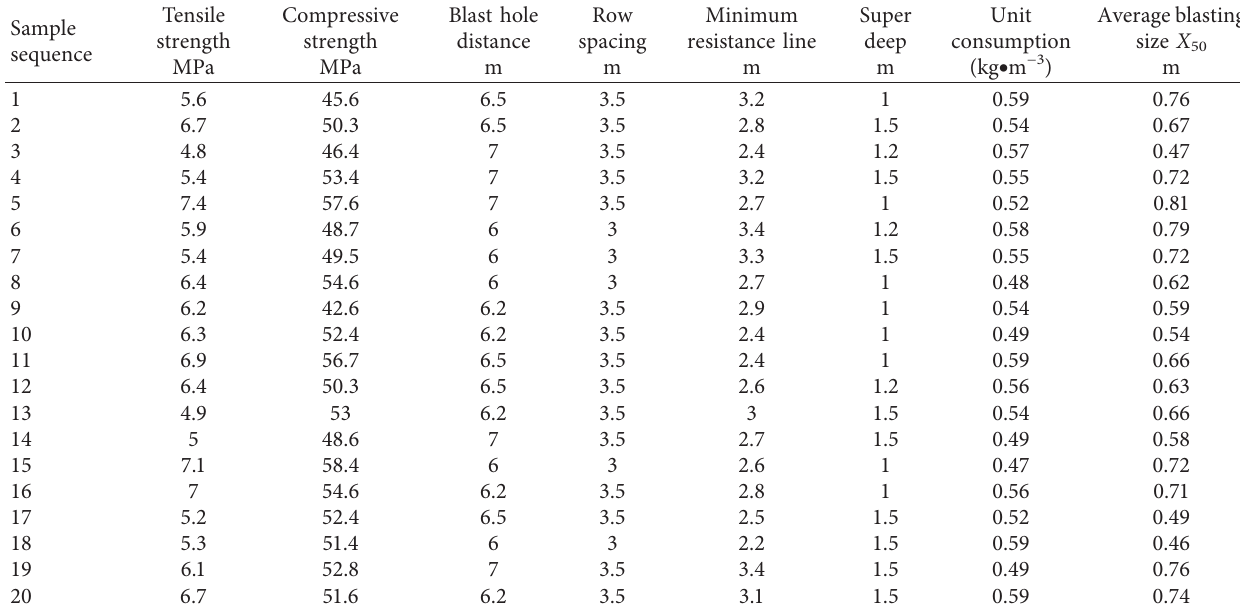
Figure 2: GWO-ELM algorithm flow. Table 1: Model training samples and prediction